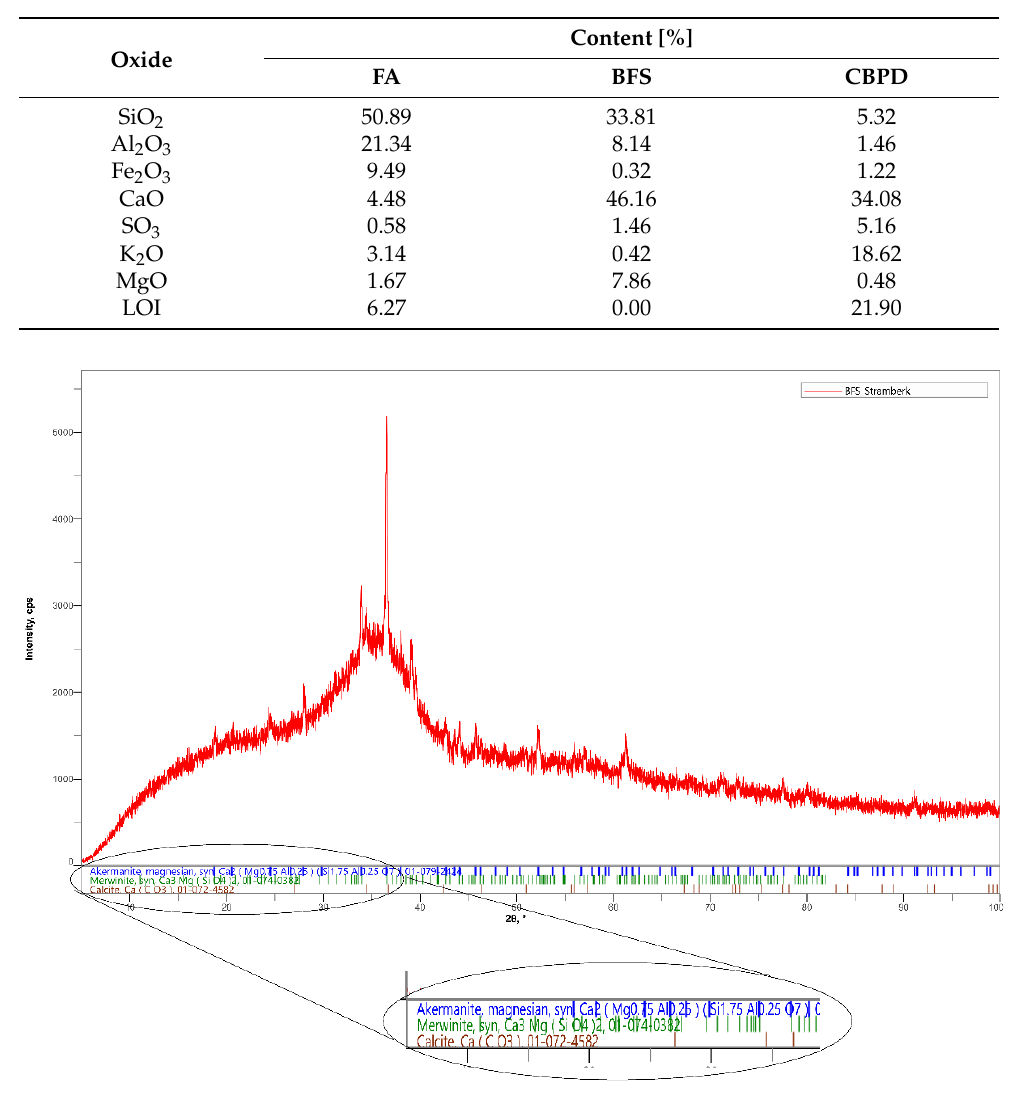
Figure 1. X-ray diffraction (XRD) pattern of Figure 1. X - ray diffraction (XRD) pattern of BFS .